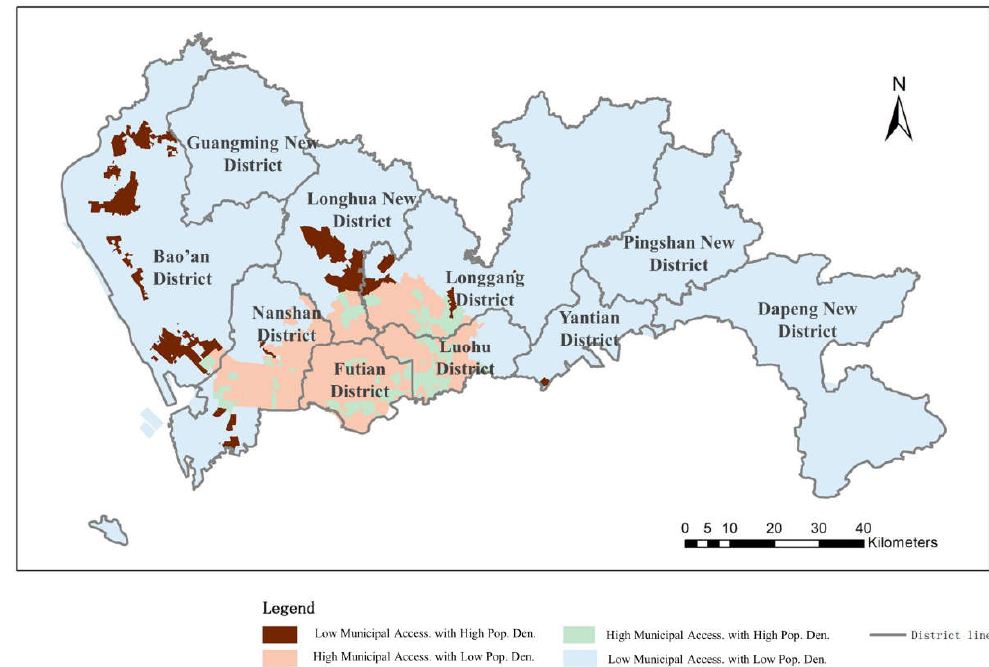
Figure 10. Balance evaluation between municipal hospital accessibility and population density.